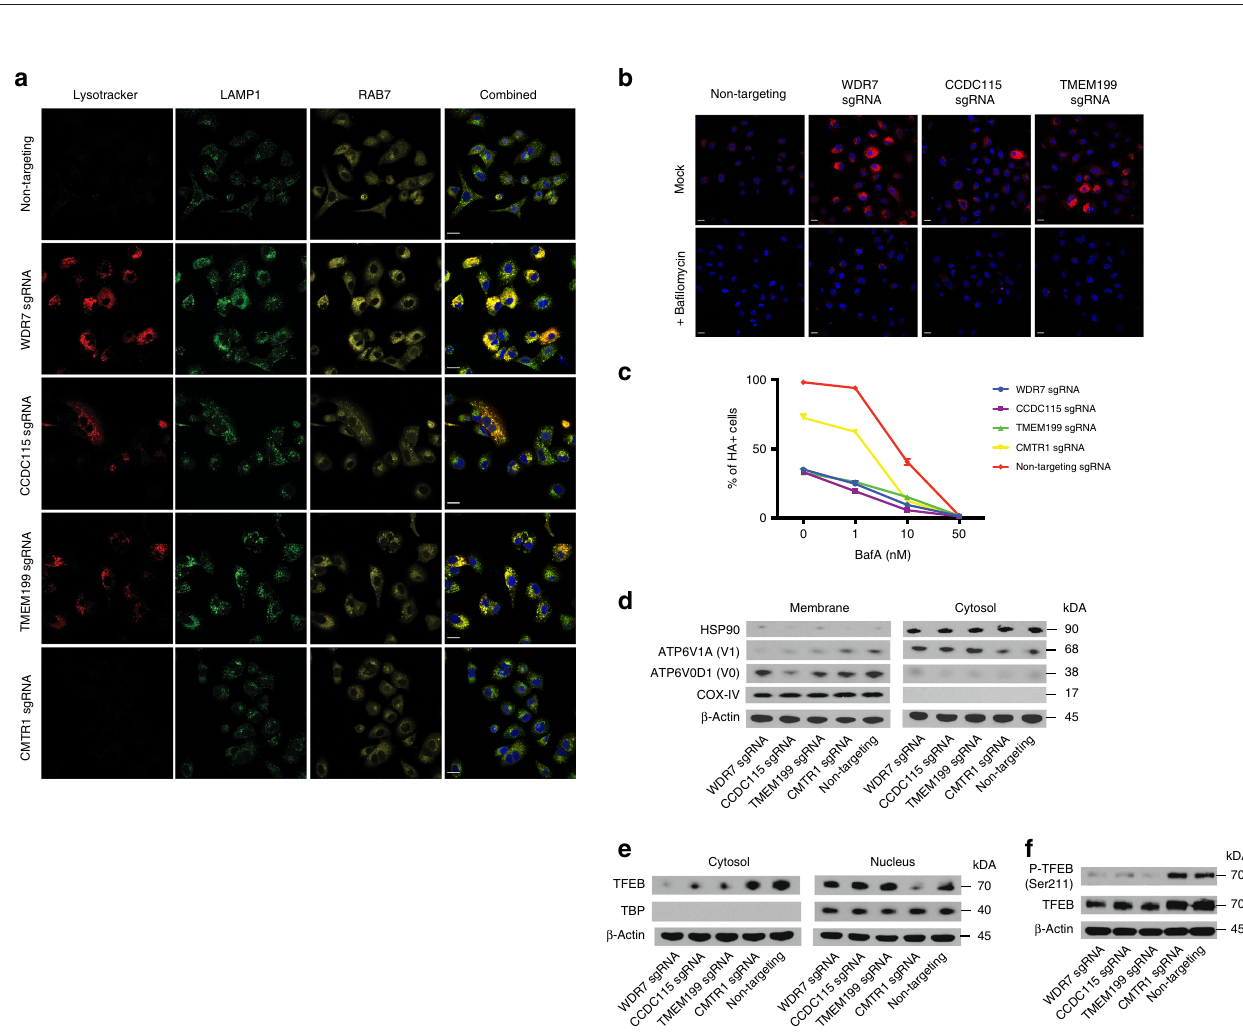
Fig. 4 WDR7, CCDC115, TMEM199 and CMTR1 are involved in early infection. a Flow cytometry and fl uorescent in situ hybridization (FISH) for in fl uenza PR8 NP protein and RNA. A549 cells were transduced with either gene-speci fi c or non-targeting sgRNA and infected with PR8 virus for 4 h. Infected cells were stained with anti-H1N1 NP antibody or NP FISH RNA probes. Bar graphs show quanti fi cation for the percentage of NP-positive cells for both protein and RNA (cells with positive FISH staining) normalized to non-targeting sgRNA. Scale bar = 20 μ m. Error bars represent standard deviation from three independent experimental replicates for NP protein staining and four randomly chosen frames for NP RNA FISH. b A549 cells were transduced with either gene-speci fi c or non-targeting sgRNA and infected with MLV-GFP reporter virus pseudo-typed with either in fl uenza PR8 HA and NA or MLV envelop proteins. Y-axis shows percentage of GFP-positive cells normalized to non-targeting sgRNA. Error bars represent standard deviations from three independent experimental replicates. c Histogram showing level of surface-bound HA (left) and sialic acid (right). A549 cells transduced with either gene- speci fi c or non-targeting sgRNA were incubated with PR8 virus for 30 min at 4 °C for monitoring level of surface-bound HA or stained with fl uorescein- labeled Sambucus Nigra Lectin for 1 h at 4 °C for surface sialic acid. Cells transduced with sgRNA targeting SLC35A1 was used as positive control. Histograms shown is representative of three independent experimental replicates. **** P = 0.0001 *** P < 0.001 and ** P < 0.01, by one-way ANOVA test.